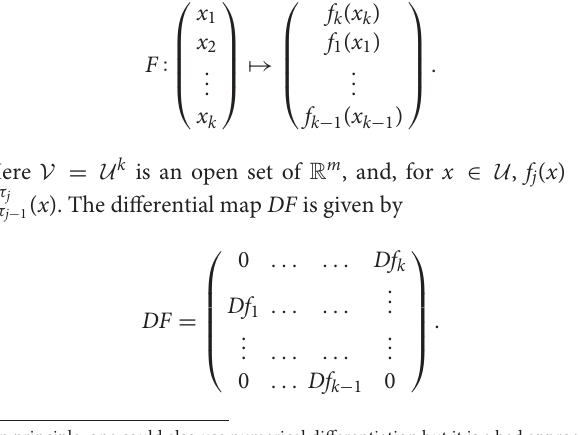
FIGURE 2 | The bicircular